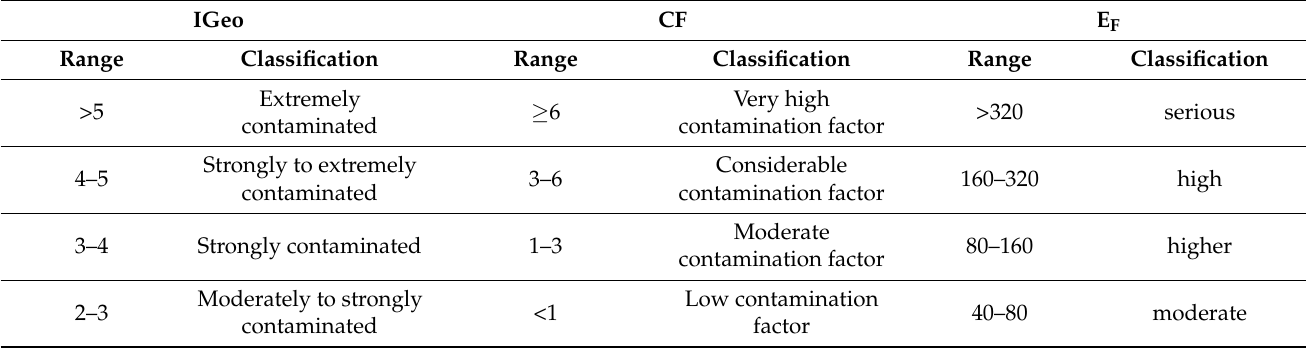
Table 3. Classification by value of geoaccumulation index (IGeo), contamination factor (CF), and potential ecological risk index (E F